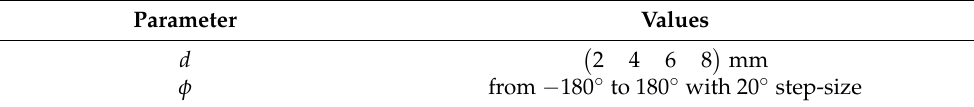
Figure 5. ( a ) Configuration of the external force on the flexible shell, ( b ) internal view of the meshed model used in the simulation. Table 2. Simulated geometric parameters and values used in finite element